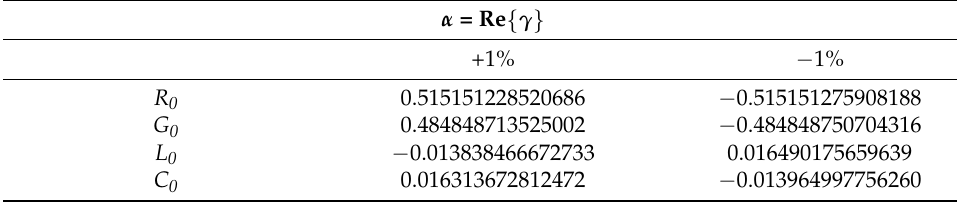
Table 2. Changes to damping constant.